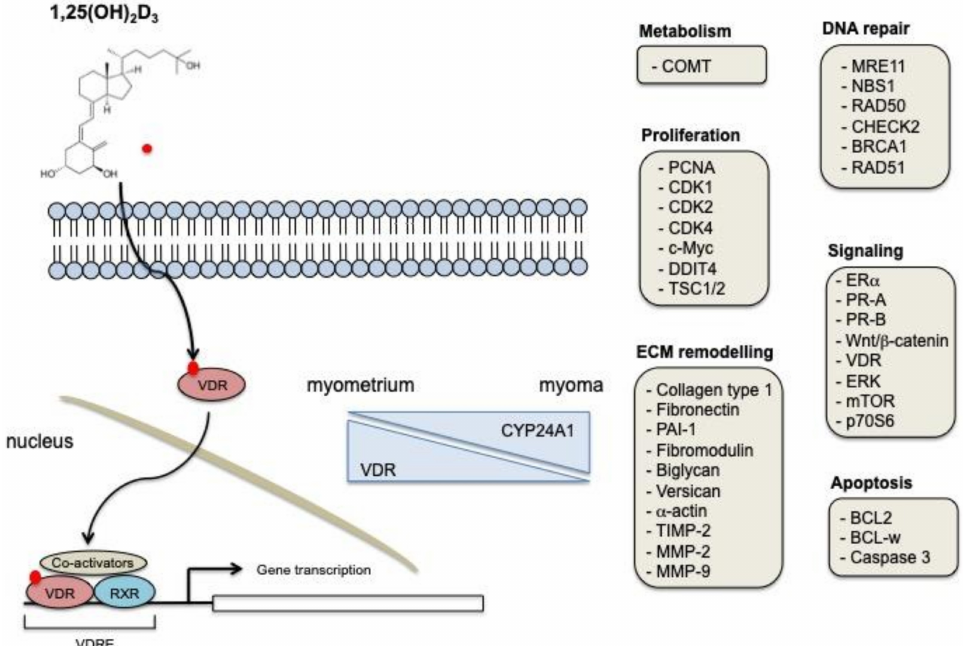
Figure 1. Biological mechanisms of vitamin D action in UFs. 1,25-dihydroxyvitamin D is the biologically active form of vitamin D. It exerts its cellular effects through the binding to VDR. The VDR-RXR complex binds to specific DNA sequences, thus regulating the expression of specific target genes. Vitamin D receptor (VDR) expression decreases in UFs samples, while CYP24A1 expression is augmented. Some of the genes and cellular processes modulated in UFs after vitamin D treatment are